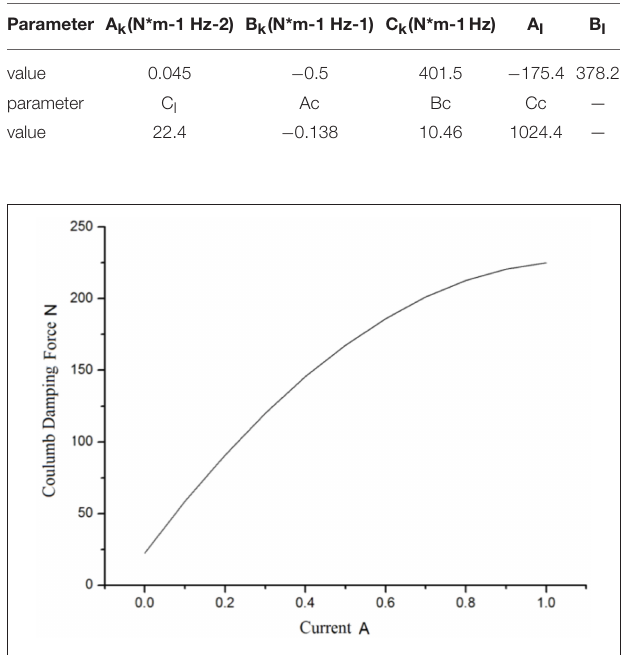
FIGURE 9 | Fitting results of MR mounts coulomb damping force.